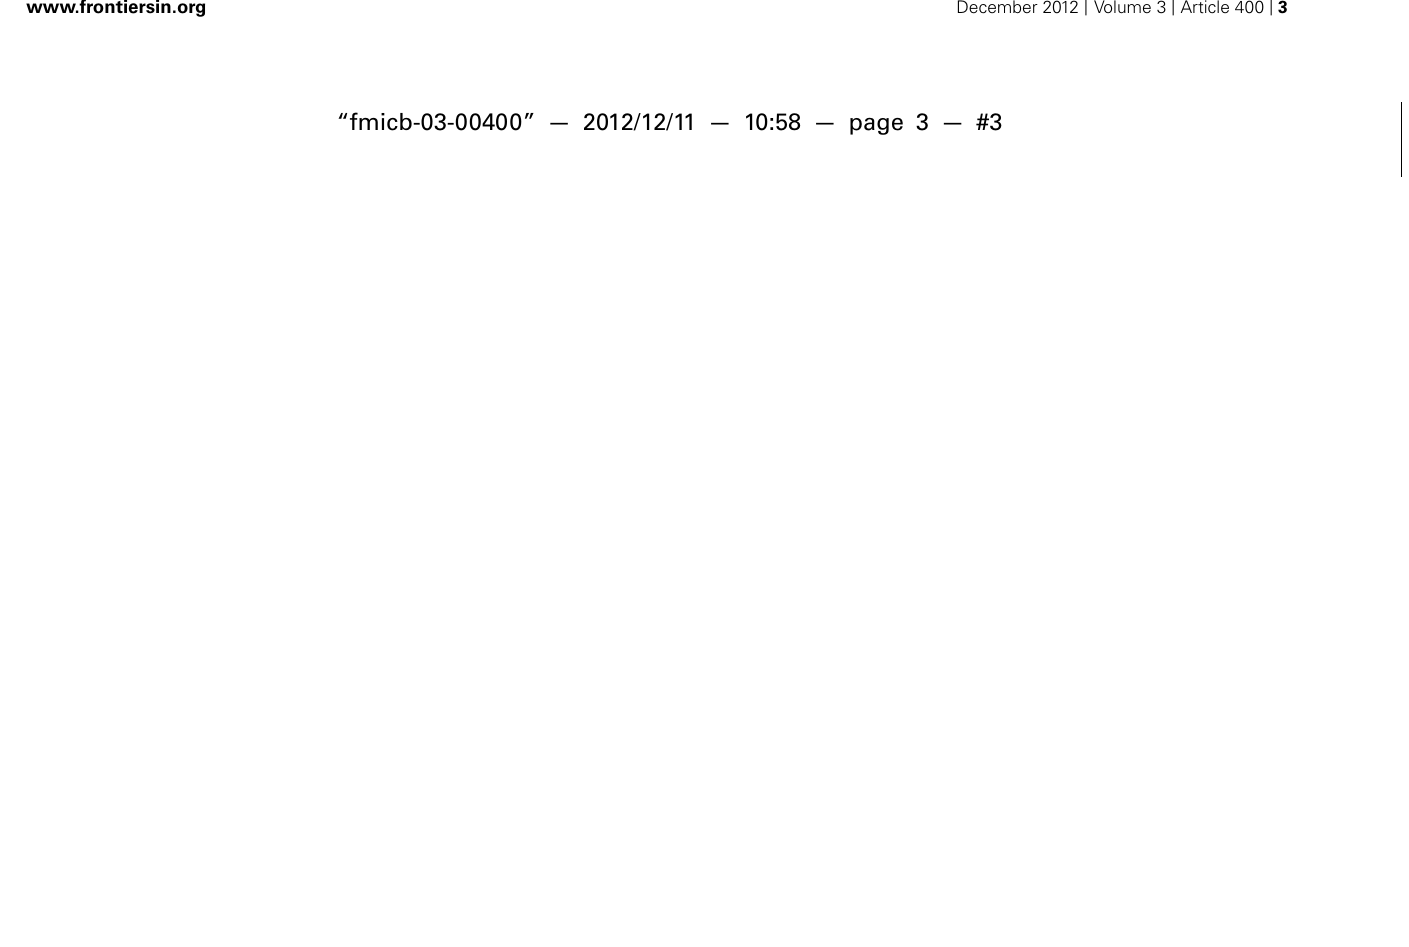
expression, viral production from transfected HTLV-1 molecular clones significantly increased. In an HTLV-1 positive ATLL cell line, the knock-down of PA28 γ increased tax/rex RNA and